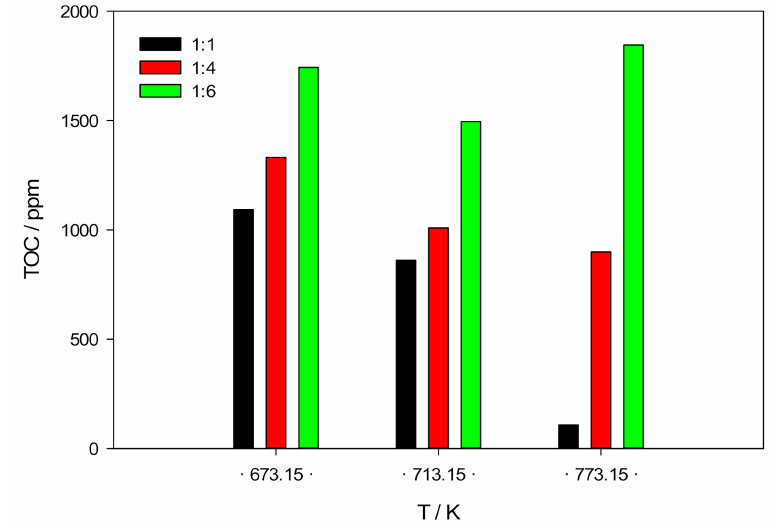
Figure 8. TOC analyses of liquid–phase products based on B:W mass